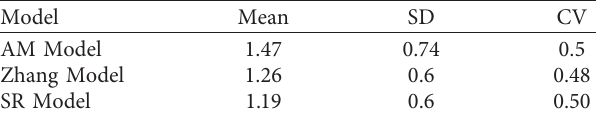
Table 10: The statistics of calculated ε under concrete crush or FRP rupture failure mode.